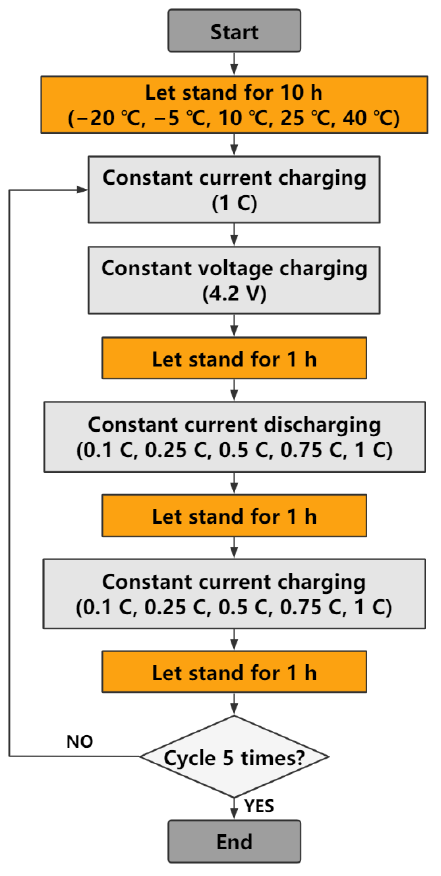
Figure 2. Experimental flow chart.